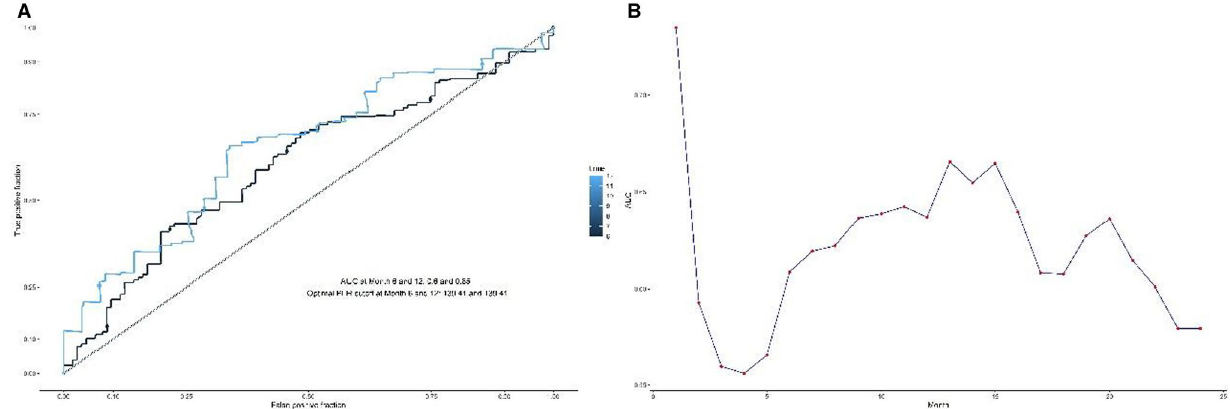
Fig. 1 A Receiver operating characteristic curves for predicting 6 months and 12 months PFS by the Platelet-to-Lymphocyte Ratio. (AUC area under the curve are 0.60 and 0.65). B AUC by PFS time